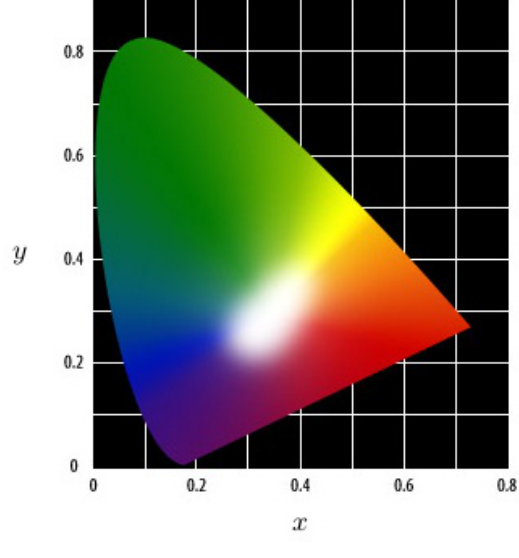
Figure 1: CIE chromaticity